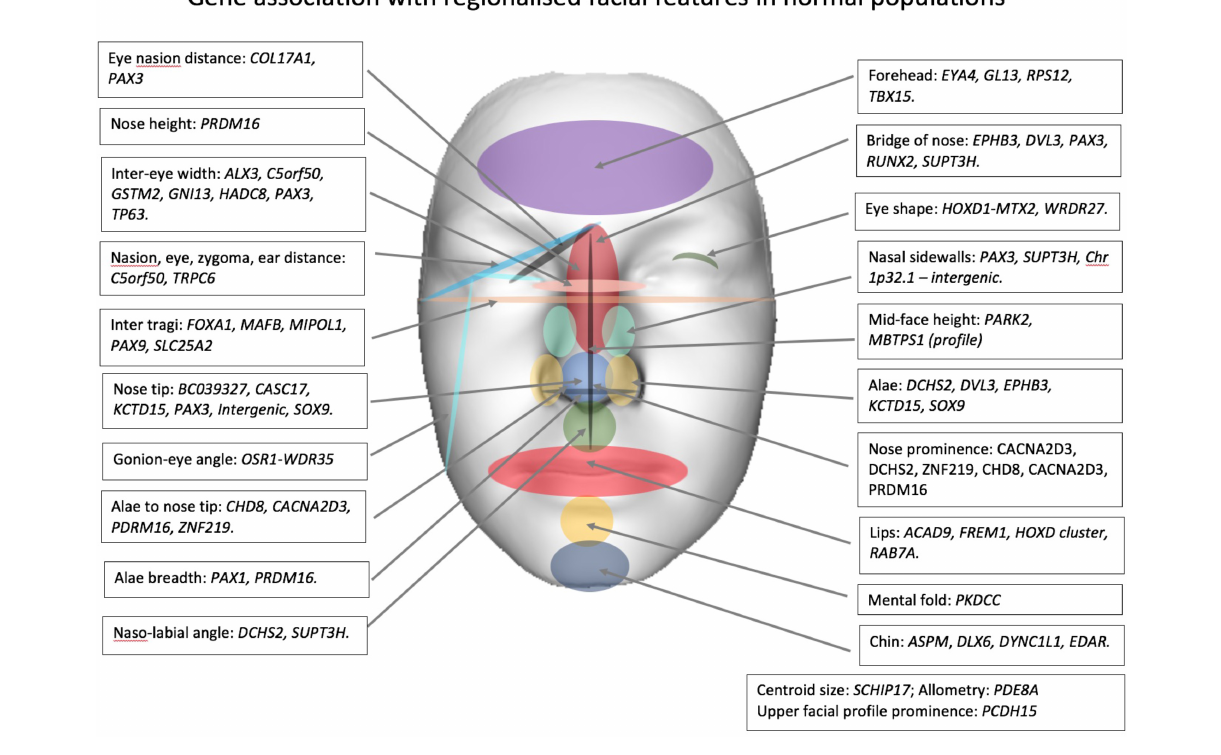
FIGURE 1 | Gene association with regionalized facial features in normal